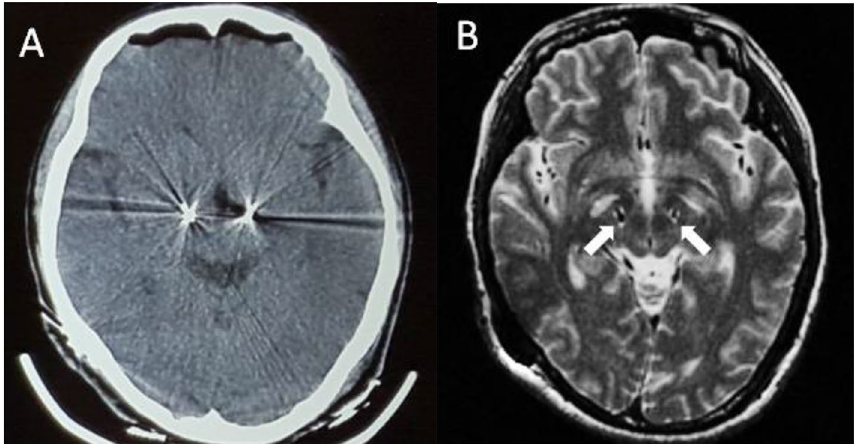
Figure 2. Case 4. Postoperative brain CT ( A ) for ruling out haemorrhage and axial T2-weighted MR images ( B ) for showing the targets location (white arrow) of the subthalamic